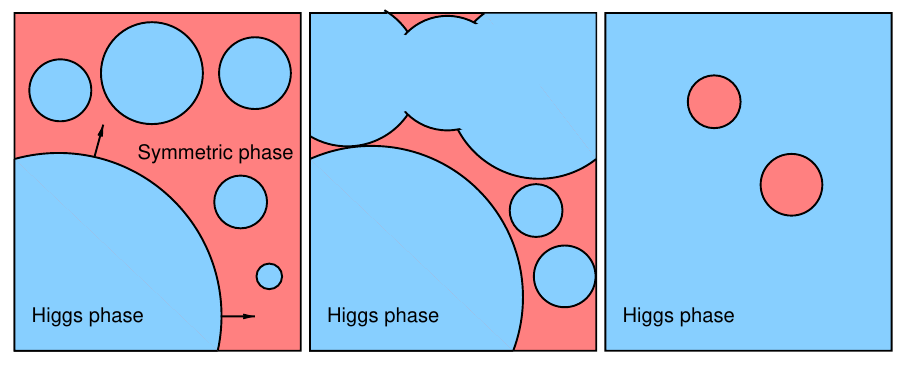
Figure 10: Due to thermal fluctuations, bubbles where the Higgs is in the stable ground state occur that expand into regions where the Higgs is still in the metastable ground state. At early times, the bubbles do not overlap, but later they combine until the entire fluid is in the stable ground